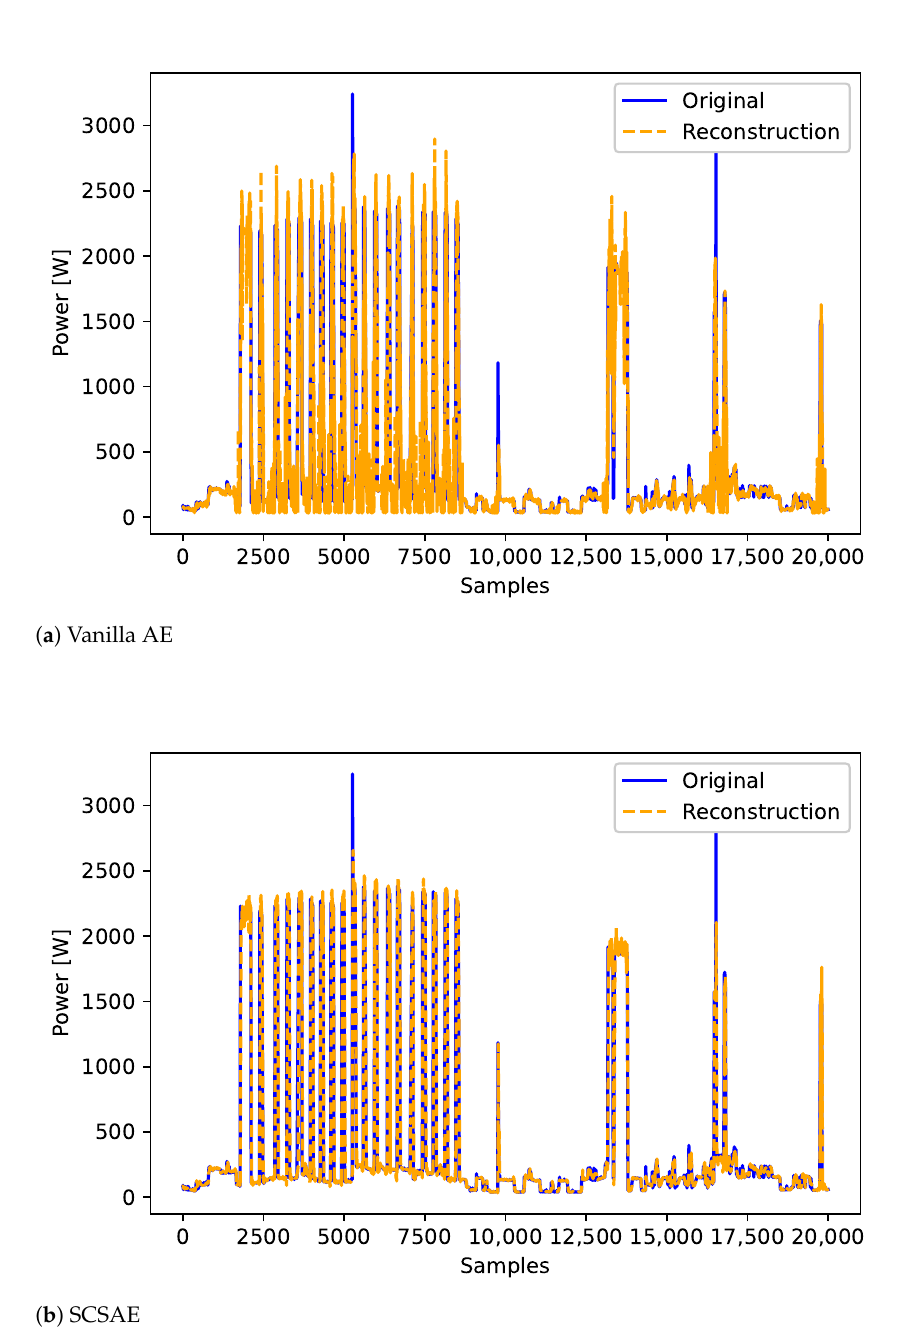
Figure 10. Reconstructed profile of each AE model. As shown in Figure 11, a comparison is made between the FS-SCSAE model applying the proposed method and the existing SCSAE model in terms of the reconstruction quality. The standard of this evaluation was the error rate of reconstructing the compressed data for different thresholds of the percentile range of PSDs. In this experiment, the thresholds were optimized. Comparing the MAE results at the optimal values, it was observed that the proposed method outperformed the existing